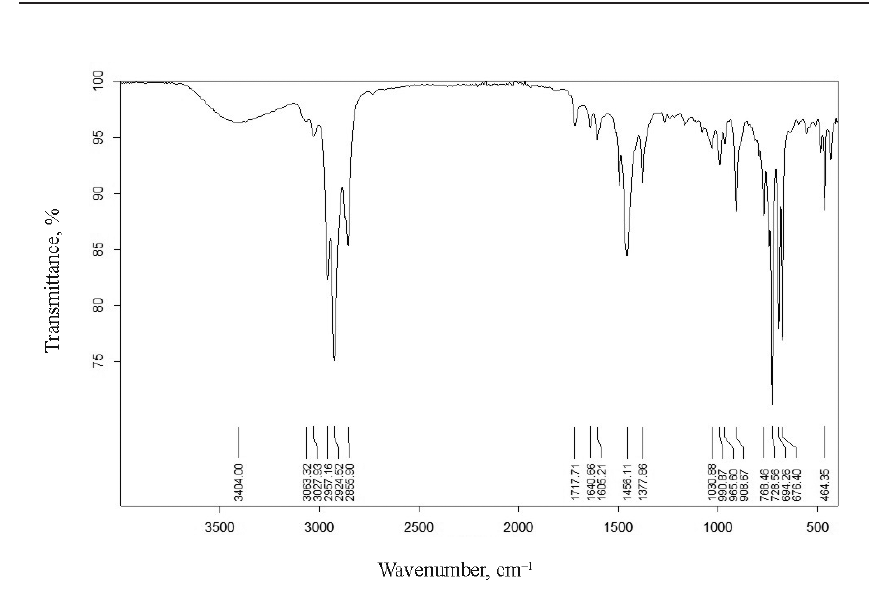
Fig. 5. The FTIR spectrum of the pyrolysis tar of Uvurjargalant oil